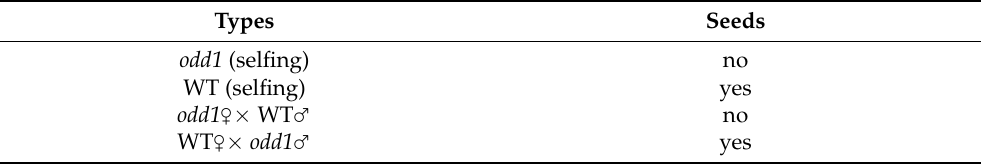
Table 2. Seed setting by selfing and